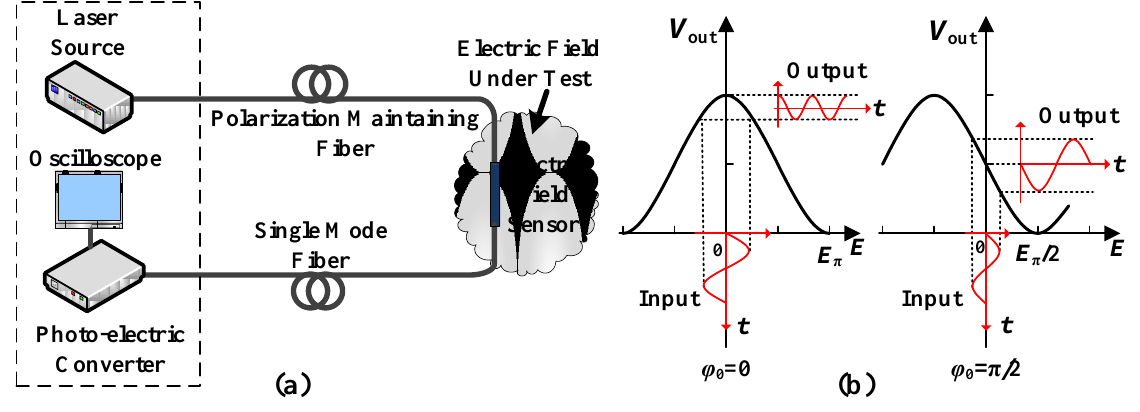
Figure 3. ( a ) Structure of the measurement system; ( b ) Transfer function with different φ